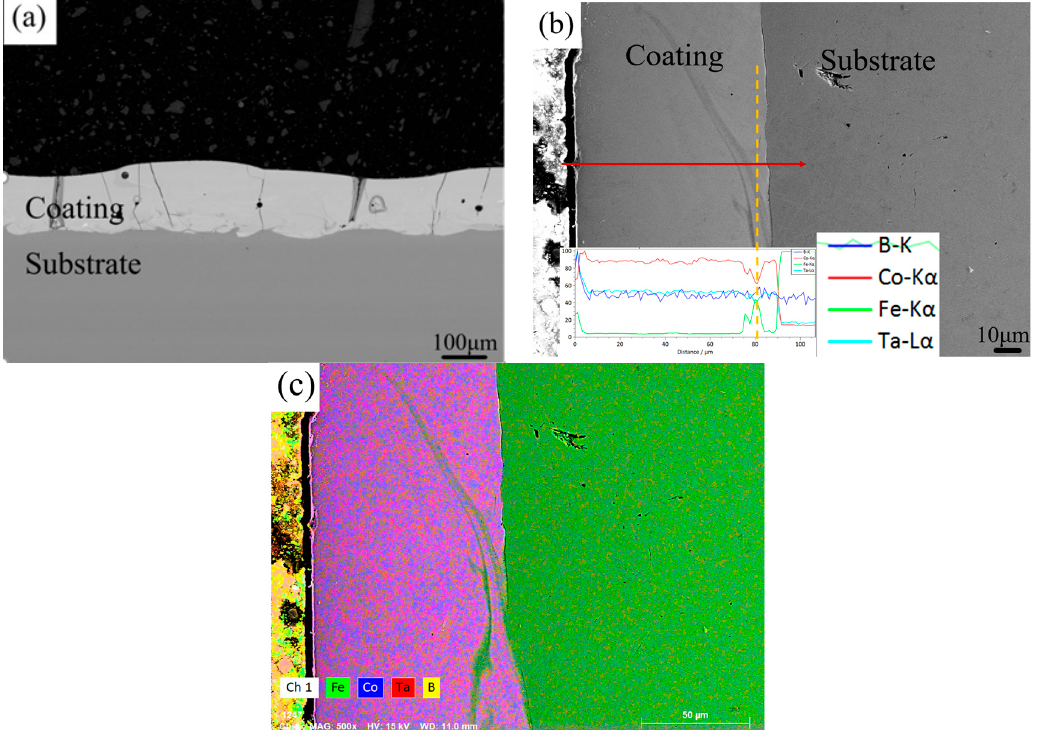
Figure 3. ( a ) Morphologies of Co 55 Ta 10 B 35 amorphous coating in the cross-section view. ( b ) Elemental distribution from the coating to the steel matrix. ( c ) Mapping of elemental distribution.